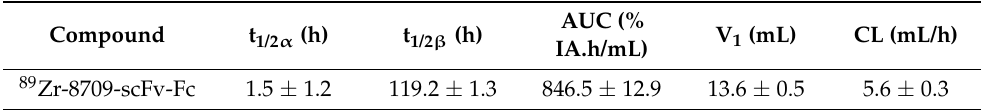
Table 1. Pharmacokinetic parameters of 89 Zr-8709-scFv-Fc ±